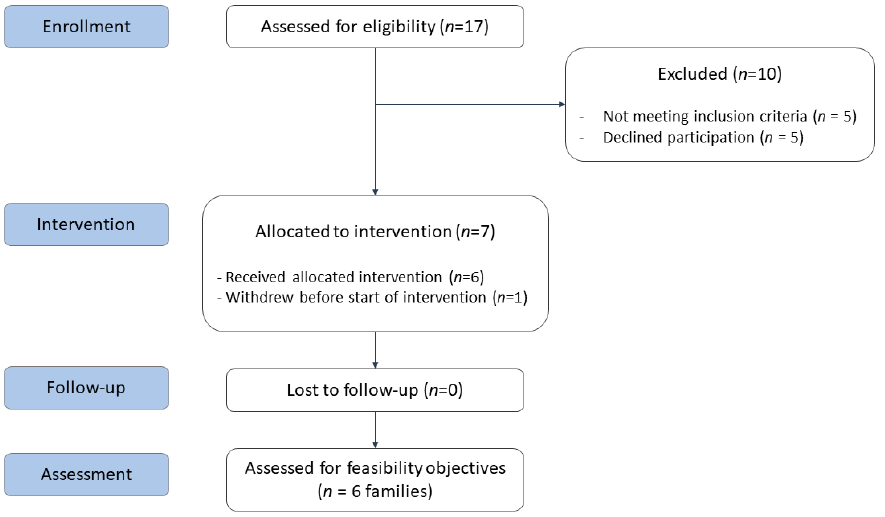
Figure 3. Illustration of the recruitment